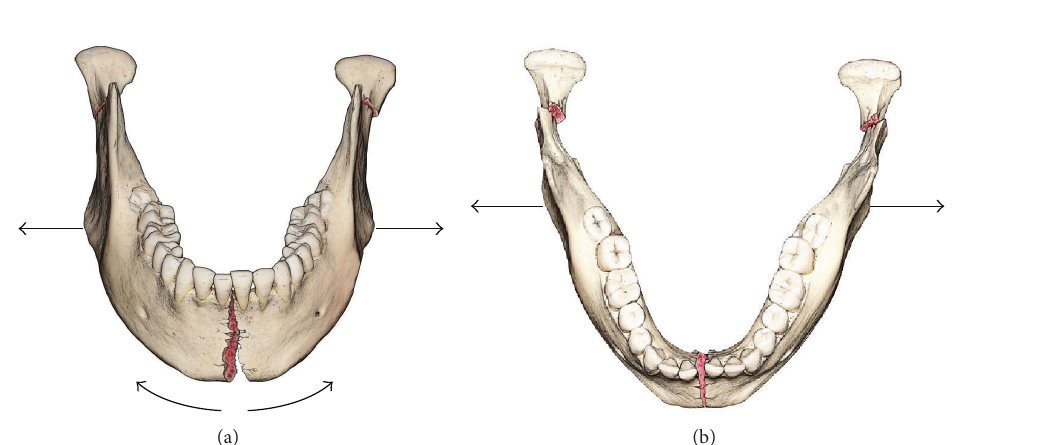
Figure 1: Illustration showing symphyseal fracture with bicondylar fractures and the resulting flaring (a) and widening (b) of the gonial angles.